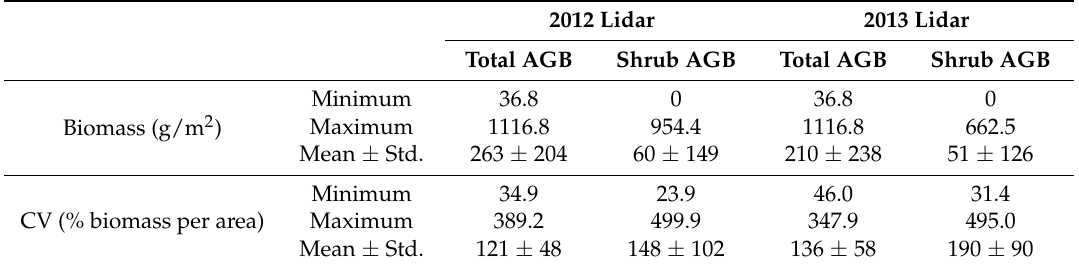
Table 6. Statistics of total and shrub imputed AGB and associated CV at